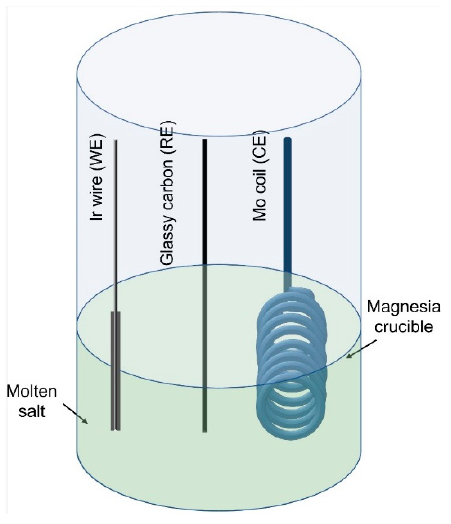
Figure 1. Schematic diagram of the electrochemical cell assembly.